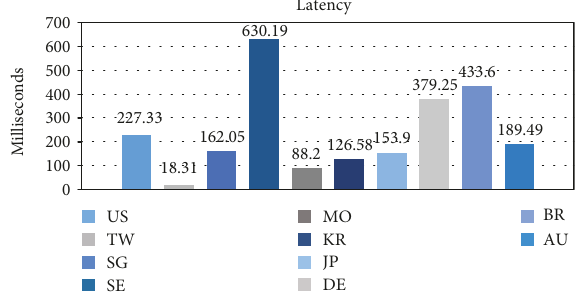
Figure 4: Geographical measurements of the blanket mode (latency).